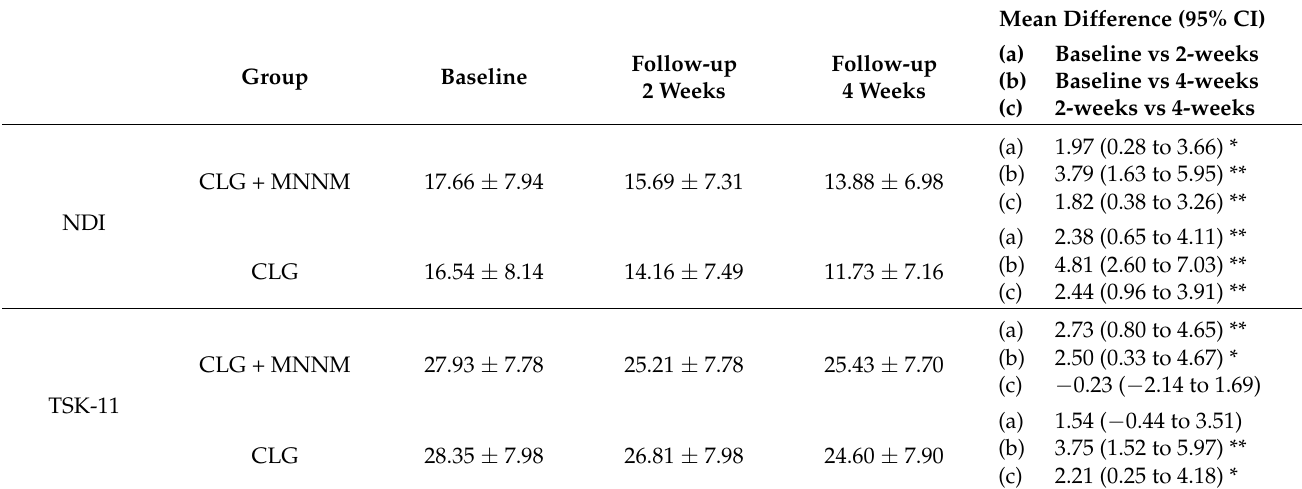
Table 5. Multiple comparisons for neck disability and kinesiophobia. Values are the mean ± standard deviation unless otherwise